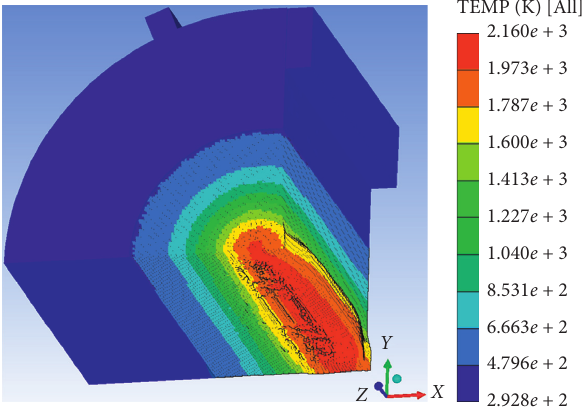
Figure 28: Comparison between simulation and acquired image ∼ 25 μ s after the impact.